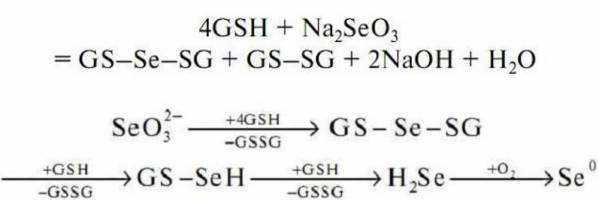
Figure 7. Scheme of sodium selenite interaction with reduced